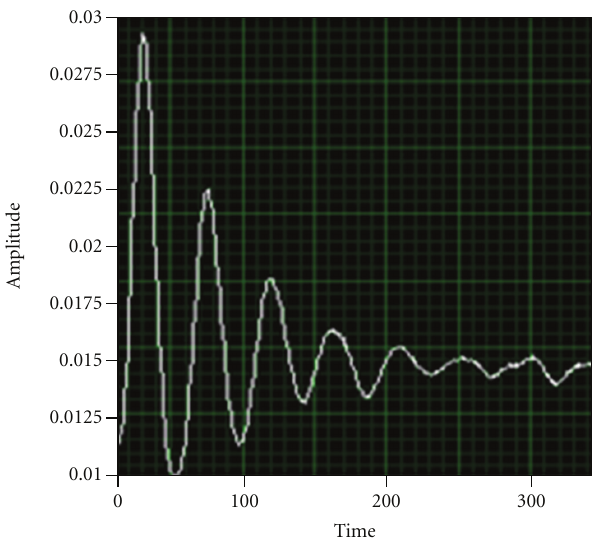
Figure 2: Temporal variation of conductivity (time in seconds). Since the distance travelled by the tracer is more than twice the length of the riser, the following equation is used to obtain conservative estimates of the liquid circulation velocity: